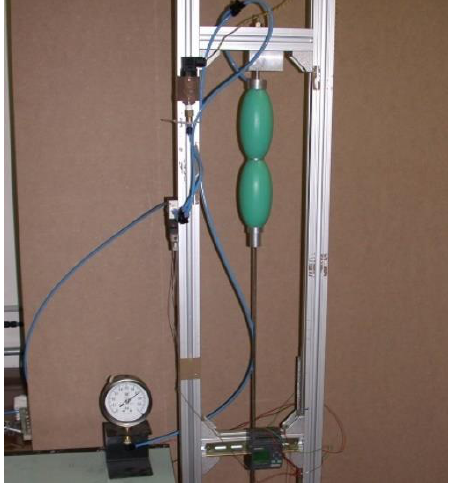
Figure 4. The test bench used for the life duration tests. It is equipped with a pressure transducer, an electric 3/2 pneumatic valve and a PLC to drive the experimental tests.